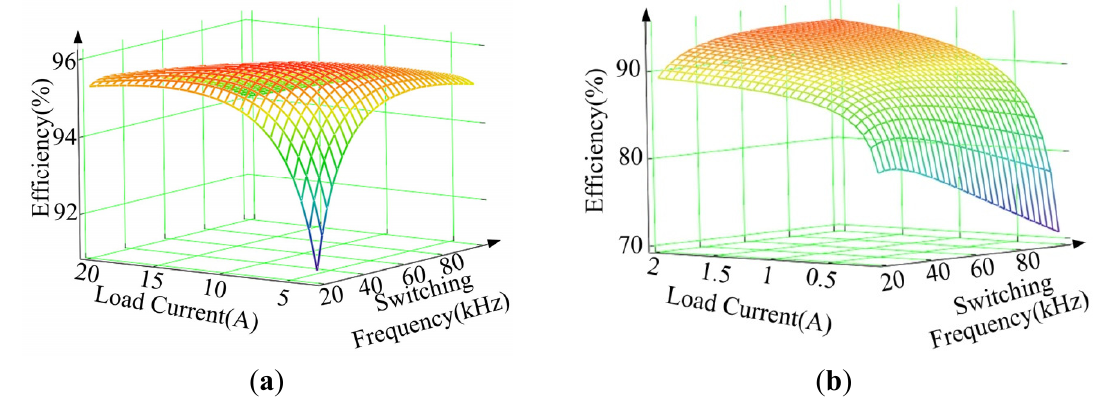
Figure 9. 3-D plots of efficiency versus frequency versus load current; ( a ) CCM; ( b ) DCM.